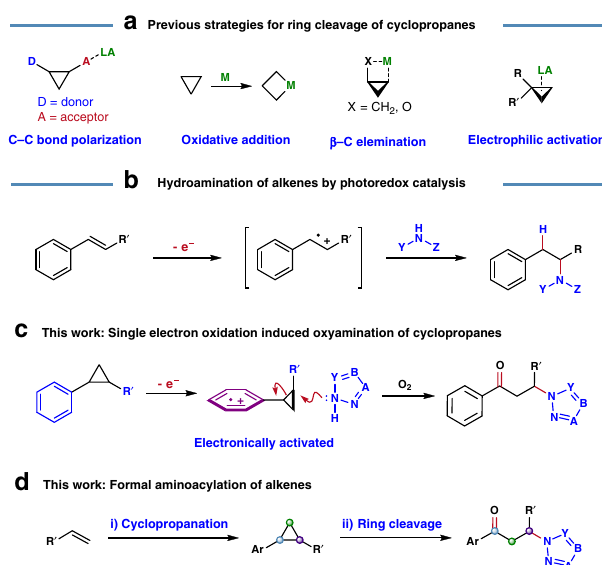
Fig. 1 Synthetic elaboration of cyclopropanes and alkenes. a Reported strategies for ring-opening functionalization of cyclopropanes. b Hydroamination of alkenes by photoredox catalysis. c Oxo-amination of unactivated aryl cyclopropanes. d One-pot aminoacylation of